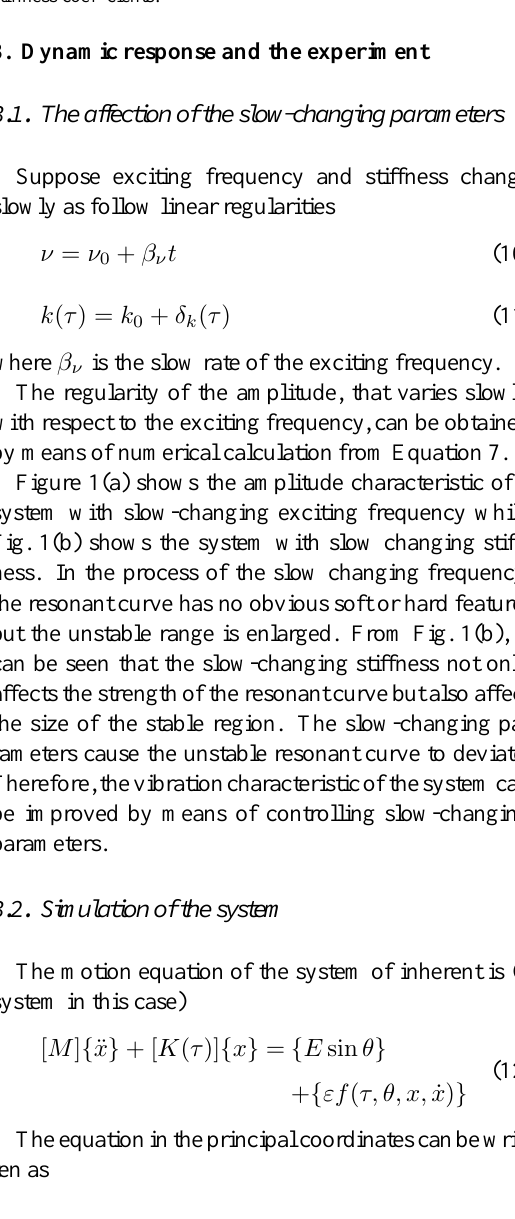
Fig. 2. The simulation curves of the system with different changing stiffness